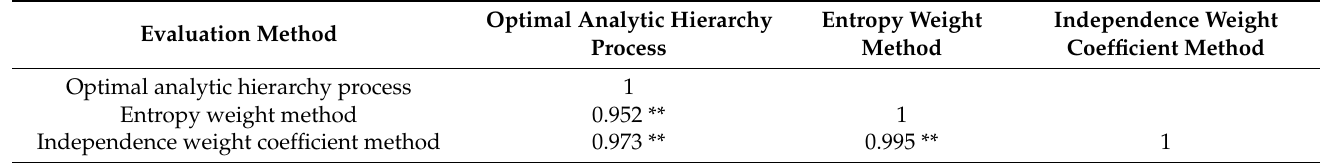
Table 9. Correlation analysis among different evaluation